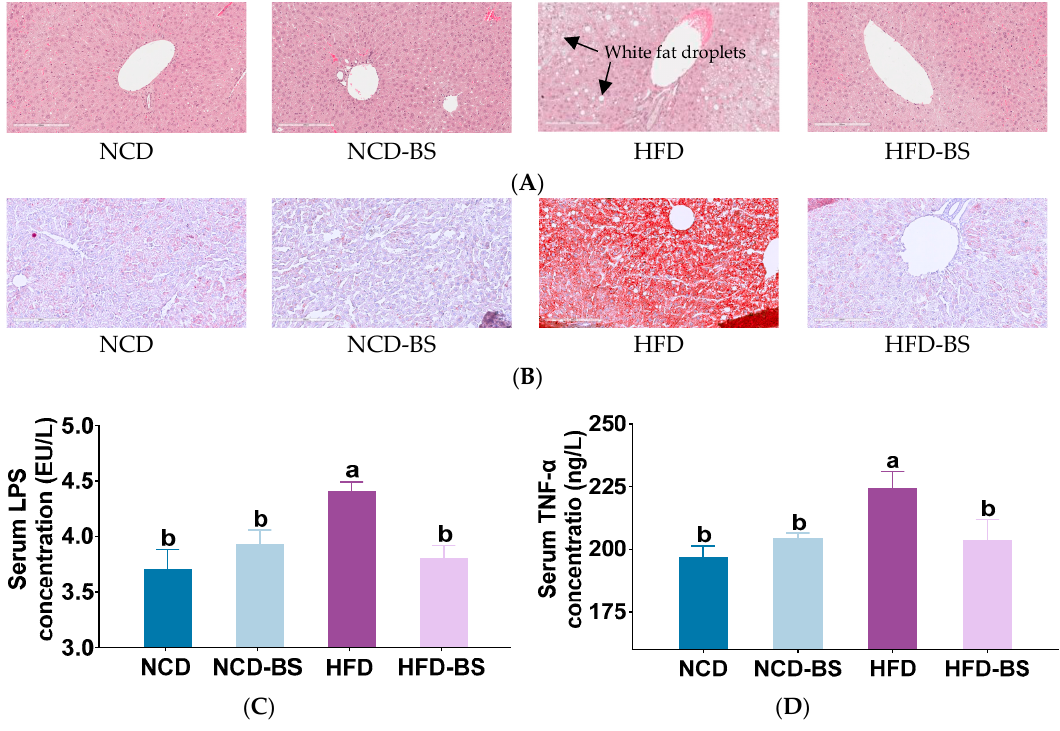
Figure 2. BS limited HFD-induced hepatic steatosis and ameliorated inflammation. ( A ) H&E staining of liver tissue, ( B ) Oil-Red O staining of liver tissue, ( C ) serum LPS concentrations, and ( D ) serum TNF- α concentrations. Data are presented as means ± SEM, n = 8 per group. Means denoted by a different letters (a, b) indicate significant differences between groups ( p < 0.05). NCD, normal control diet; NCD-BS, normal control diet supplemented with freeze-dried powder of bamboo shoots; HFD, high-fat diet; HFD-BS, high-fat diet supplemented with freeze-dried powder of bamboo shoots.